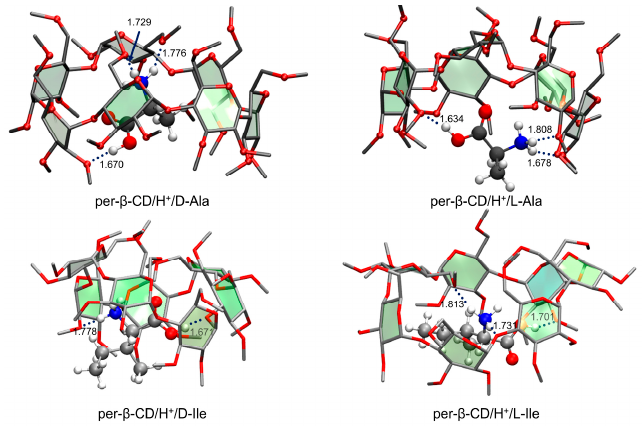
Figure 15. The most stable conformers of per- β -CD / H + / Ala and / Ile complexes. Reproduced from Reference [59,60] by permission of the PCCP Owner